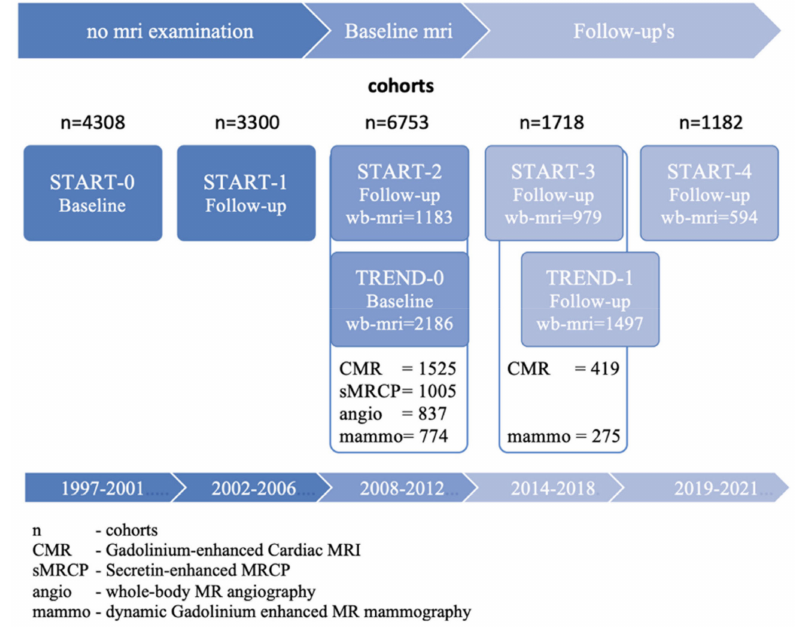
Figure 1. Timeline of SHIP